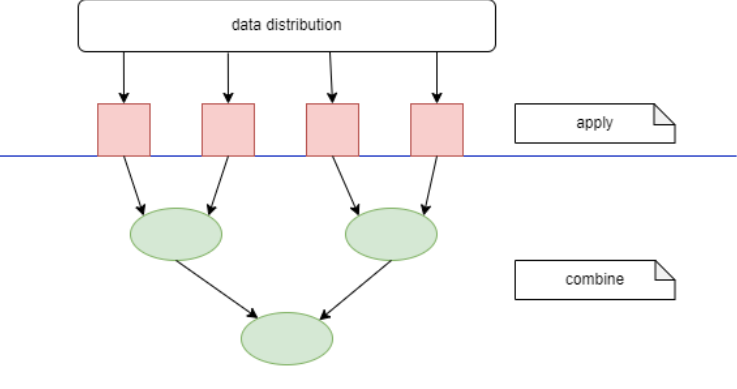
Figure 2. Tree-like execution for a divide-and-conquer of type AC with k equal to 2 and n equal to 4. On the distributed memory platforms, the execution has to start with data distribution, through which the processes will receive the needed